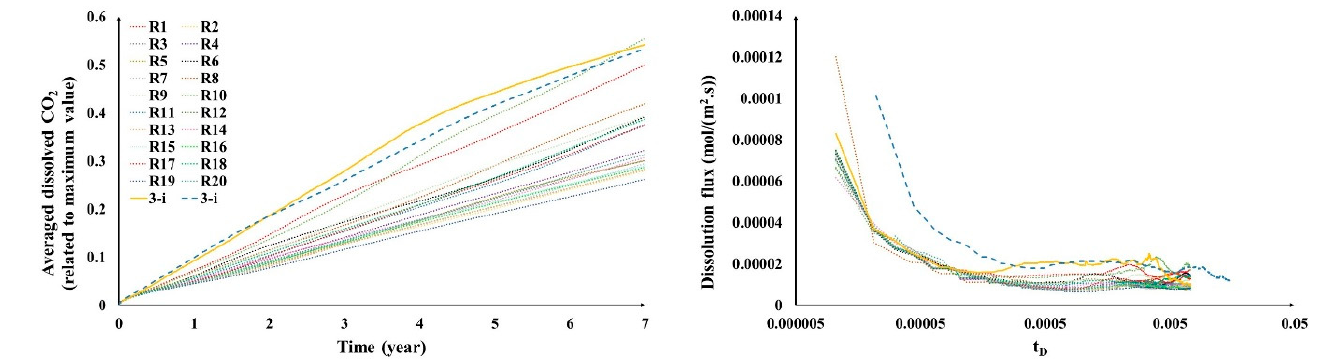
Figure 10. The heterogeneous realizations (dotted lines), homogeneous with considering cross-dif- fusion (solid line), and homogeneous without considering cross-diffusion (dashed line) averaged dissolved CO 2 and dissolution flux for case 4-i. Legends for left- and right-hand subplots are same.